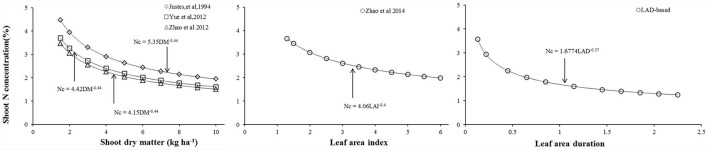
Comparisons of critical dilution curves based on different methods.